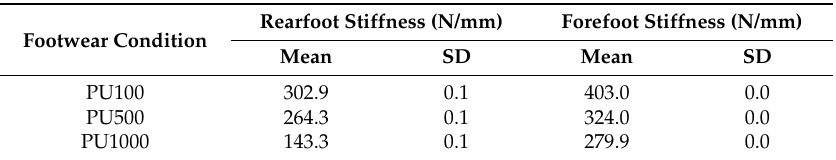
Table 1. Group mean ± standard deviation (SD) for mechanical testing of the three footwear conditions (PUMA Speed 100 (PU100); PUMA Speed 500 (PU500); PUMA Speed 1000 (PU1000)) for rearfoot and forefoot stiffness; statistical significance ( p < 0.05), and large effects ( d ≥ 0.8) were found between all footwear conditions for both foot